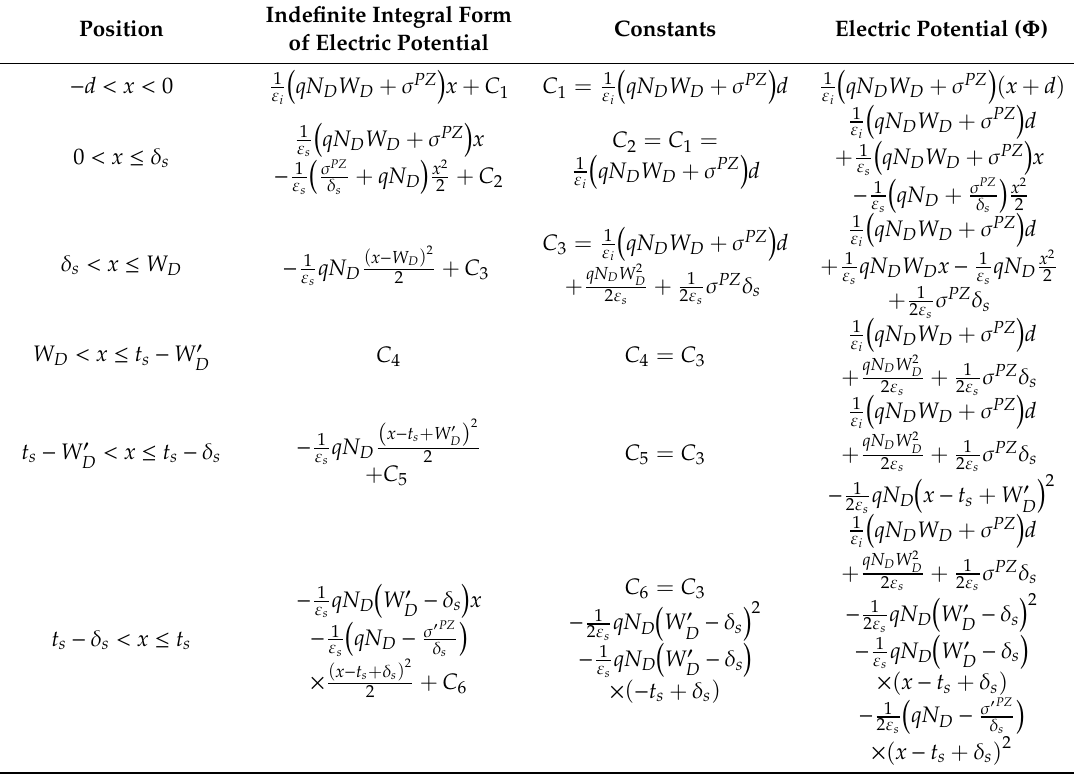
Table A8. Derivations of electric potential distribution of the piezoelectric MIS structure. Indefinite Integral Form Constants Electric Potential ( Φ Position of Electric Potential